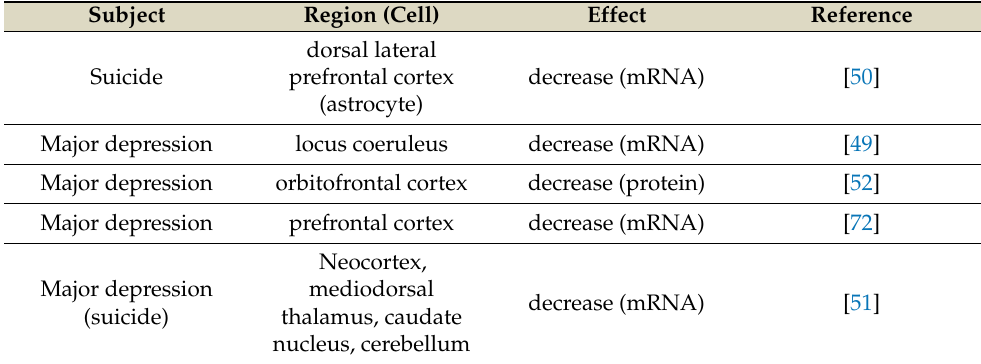
Table 1. Abnormalities of Cx43 expression of patients with mood